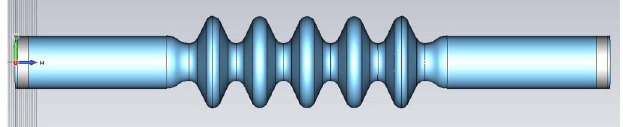
FIG. 8. Model of the ECX five-cell cavity used for MWS simulation.